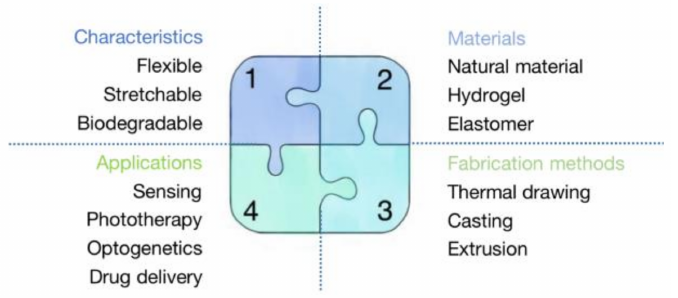
Figure 1. A summary of this review about biocompatible and biodegradable polymer optical fibers.